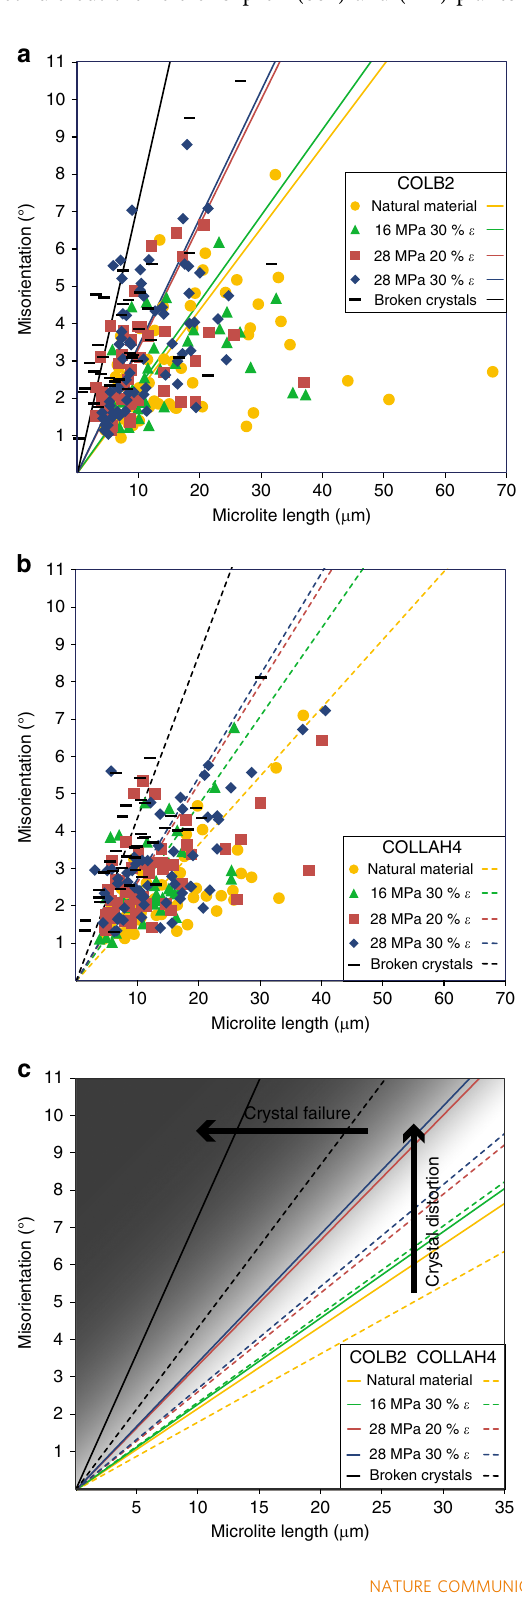
Fig. 5 Quanti fi ed lattice distortion in microlites. Misorientation value versus crystal length for all the microlites analysed for a COLB2 and b COLLAH4 starting material, samples deformed at 16 MPa to 30% strain, 28 MPa and 20% strain, 28 MPa and 30% strain or broken crystals across all sample sets (only misorientation from plastic deformation were considered in these data). The points shown indicate an increase in misorientation and shortening length (grain size reduction) with increasing deformation, and correspond to the data in Supplementary Fig. 7 and Supplementary Data 1 – 11. The gradients of the lines depicted indicate the mean misorientation per micron for microlites in each given sample set (see also Fig. 6), highlighting the effect of increasing stress and strain on crystal plasticity. c The lines taken from a and b show how increasing stress or strain increases the measured value of misorientation for a given sample length, with the highest (crystal plastic) misorientation values in the broken crystals in both COLB2 and COLAH4, suggesting they may have reached and exceeded a plastic limit. It also shows higher deformation in the less porous COLB2, in both the starting materials and at every stage of sample deformation, suggesting a higher degree of interaction between